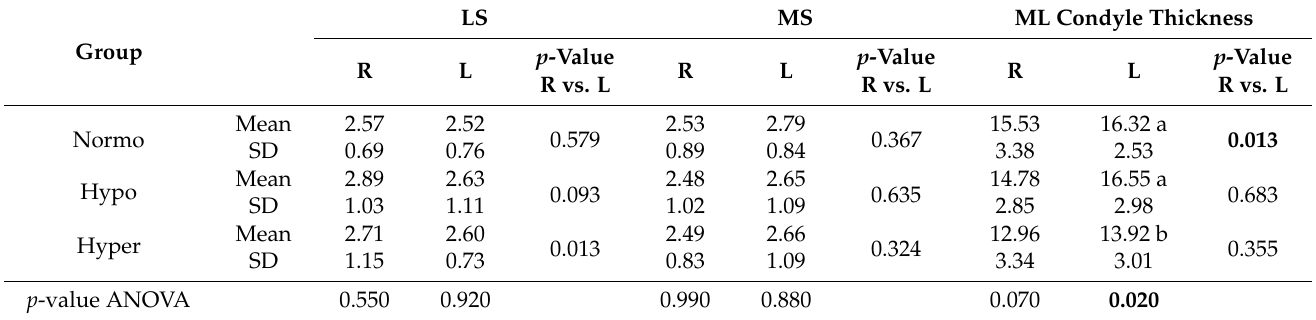
Table 3. Right (R) and Left (L) coronal variables, reported as means (mm or ◦ ) and Standard Deviations (SD) in the three study groups (Normo: Normodivergent; Hypo: Hypodivergent; Hyper: Hyperdivergent). Statistically significant p -values are reported in bold. Different letters indicate statistically significant difference between groups in the Tukey Post Hoc Test.